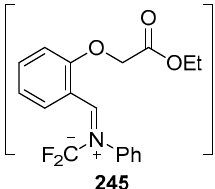
Figure 4. Analogous azomethine ylide that fails to undergo intramolecular cycloaddition.